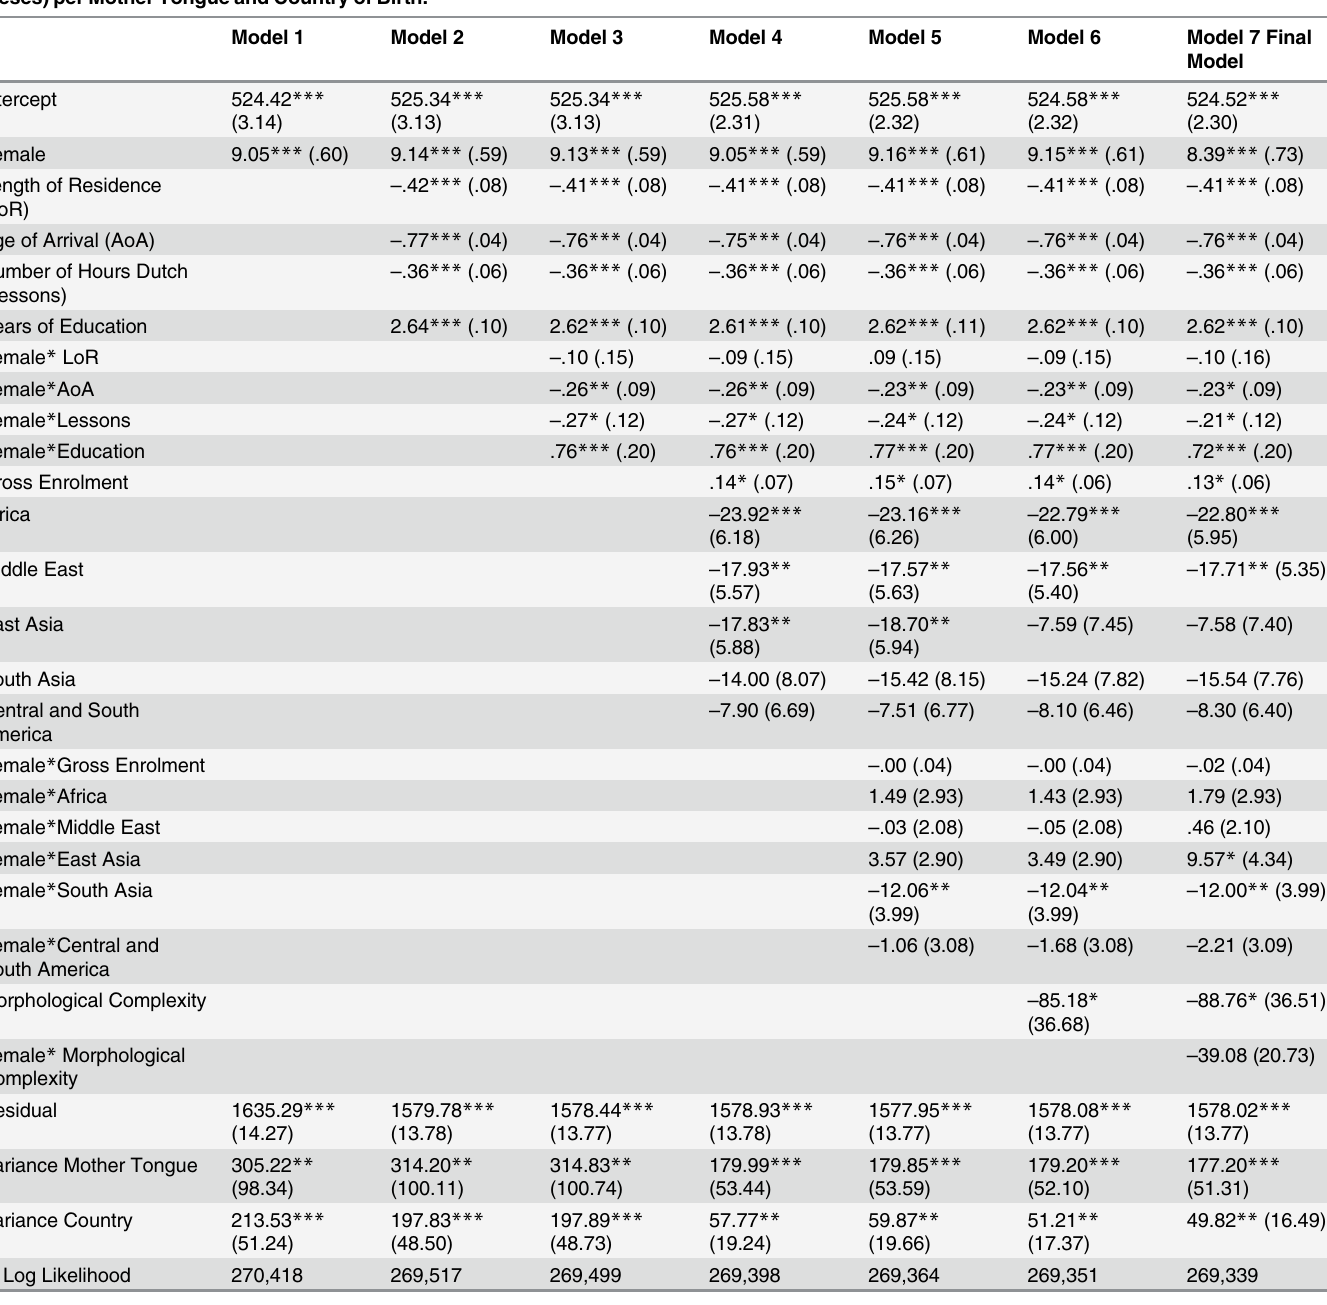
Table 3. Cross-classified Multilevel Model Parameter Estimations for Measures of the Dutch Writing Proficiency Test (Standard Errors in Paren- theses) per Mother Tongue and Country of